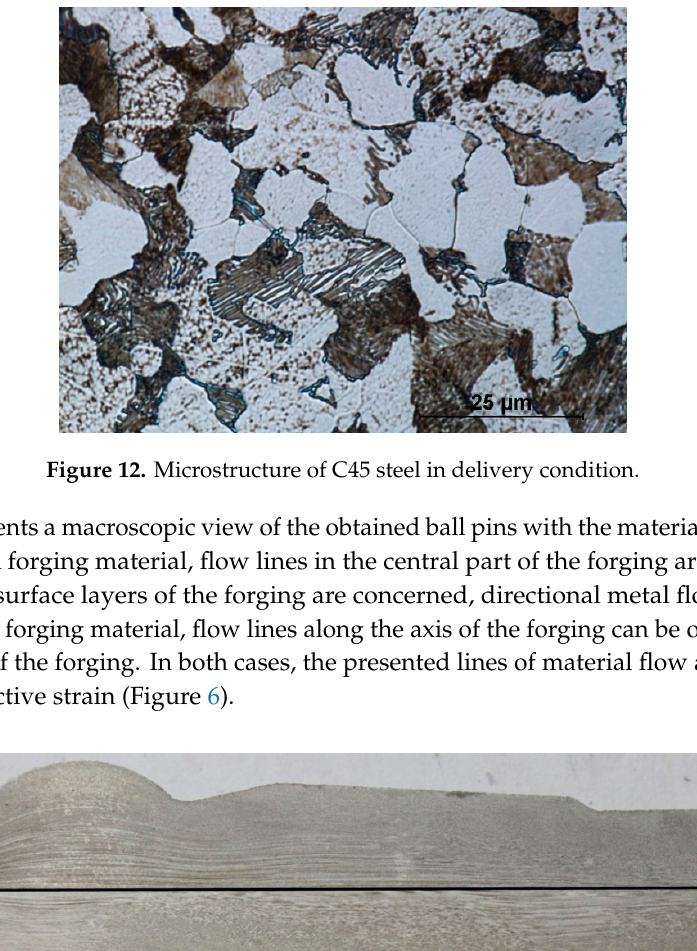
Figure 13. Material flow lines observed after etching in Jacewicz’s reagent (38 cm 3 HCL + 12 cm 3 H 2 SO 4 (1.83 g/cm 3 ) + 50 cm 3 H 2 O).